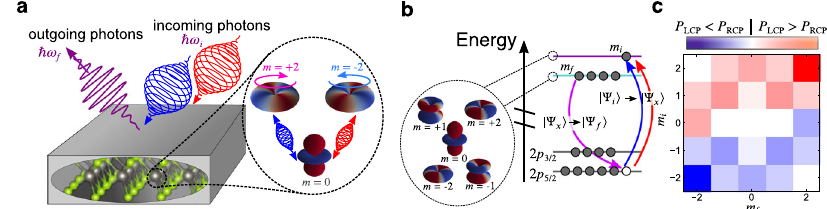
Fig. 1 Sketch of the setup and dichroic selection rules. a We investigate resonant inelastic X-ray scattering (RIXS) with circularly polarized photons (with energy ℏ ω i ) impinging on a sample, while scattered photons (with energy ℏ ω f ) are detected without resolving their polarization. This setup is sensitive to local magnetic orbital excitations, which are controlled by the circular polarization of the incoming light. b Sketch of d - d excitations in the RIXS process: upon absorbing a circularly polarized photon, an electron is promoted from the 2 p core levels to an unoccupied state in the d manifold with magnetic quantum number m i . A fi lled d orbital (quantum number m f ) relaxes and fi lls the core hole. Effectively, this corresponds to an excitation within the d orbital space. c Circular dichroism of the d - d transition probability P resolved with respect to the magnetic quantum number of the d